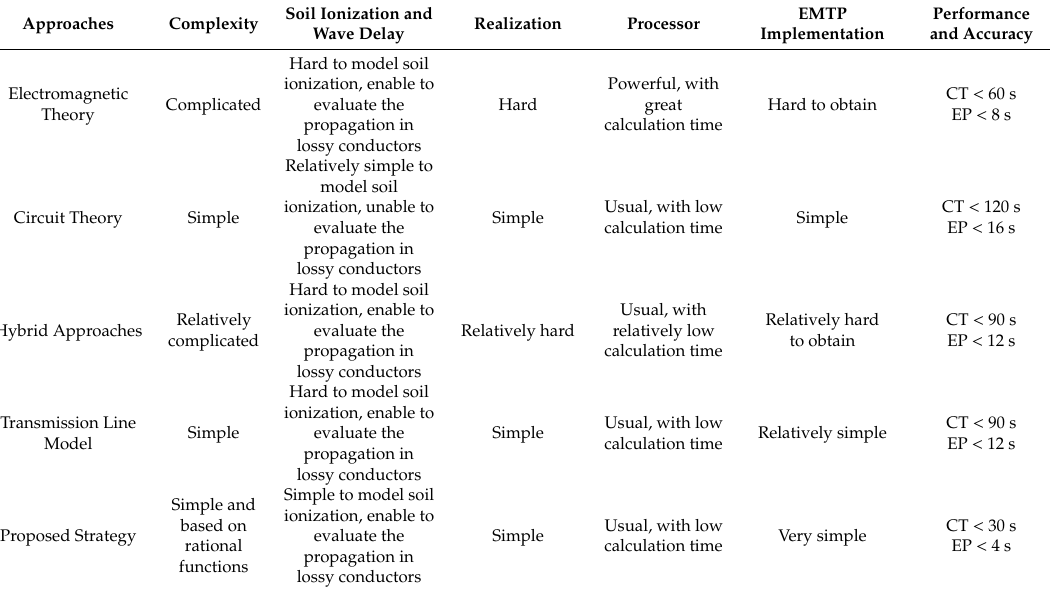
Table 1. Prototype specifications. PPF: passive power